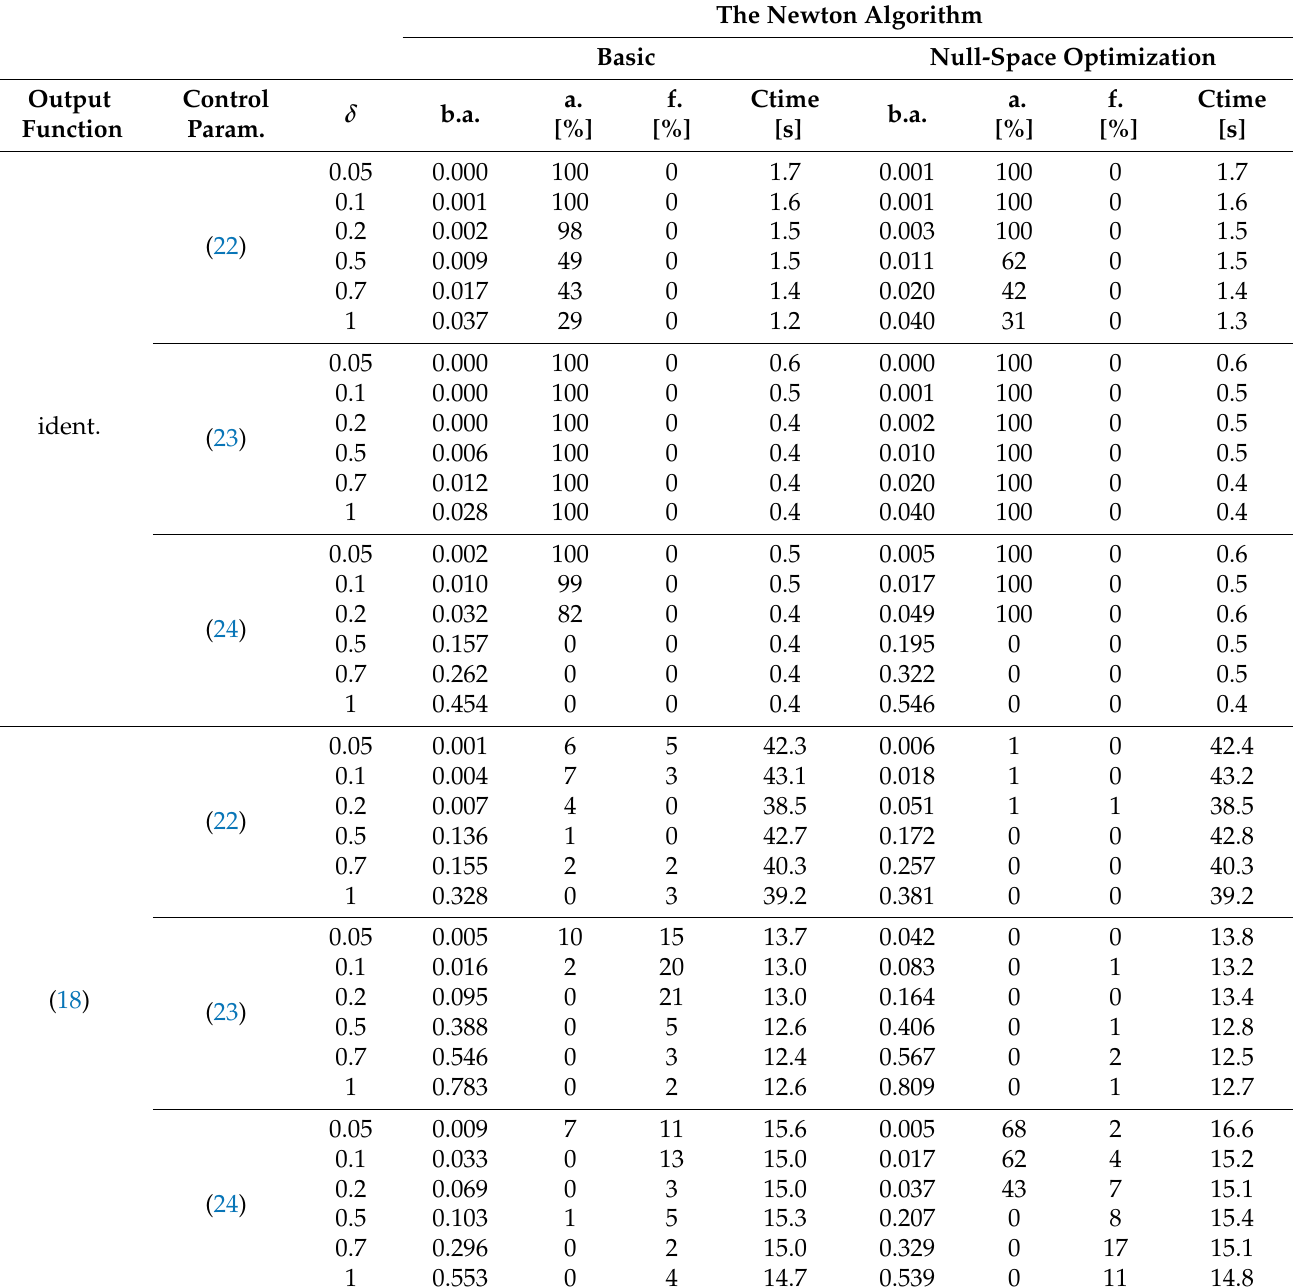
Table 2. Accuracy, numeric failures, and computing time for the unicycle